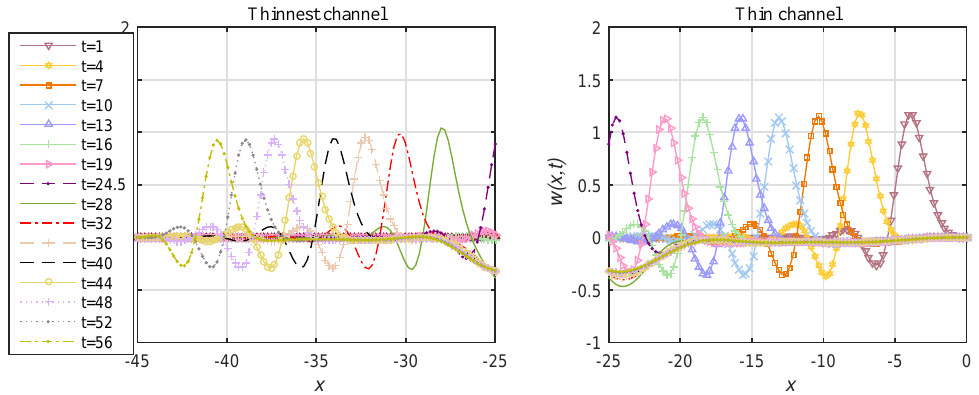
Figure 11. The experiment with α 3 = 4.9 α 2 ; the time ranges from t = 1 to 56.